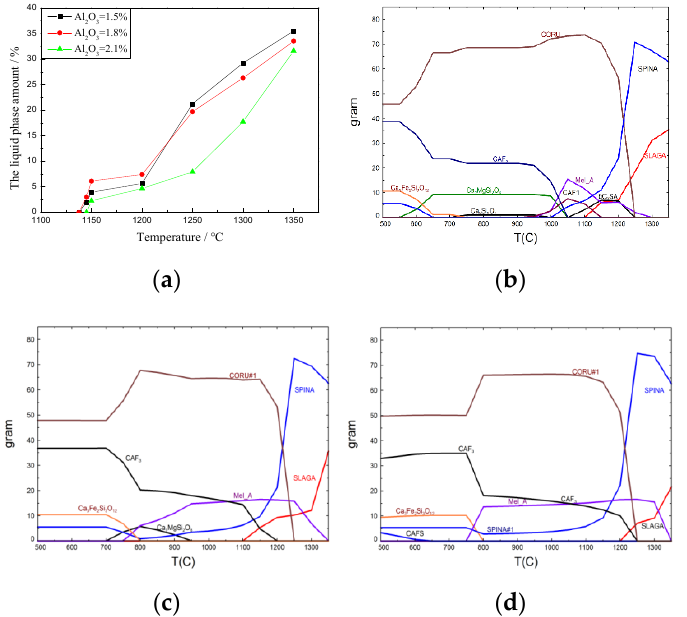
Figure 10. Mineral composition and liquid phase amount of the sinter material with different Al 2 O 3 contents. ( a ) Liquid phase amount of sinter; ( b ) Al 2 O 3 content of 1.5%; ( c ) Al 2 O 3 content of 1.8%; ( d ) Al 2 O 3 content of 2.1%.